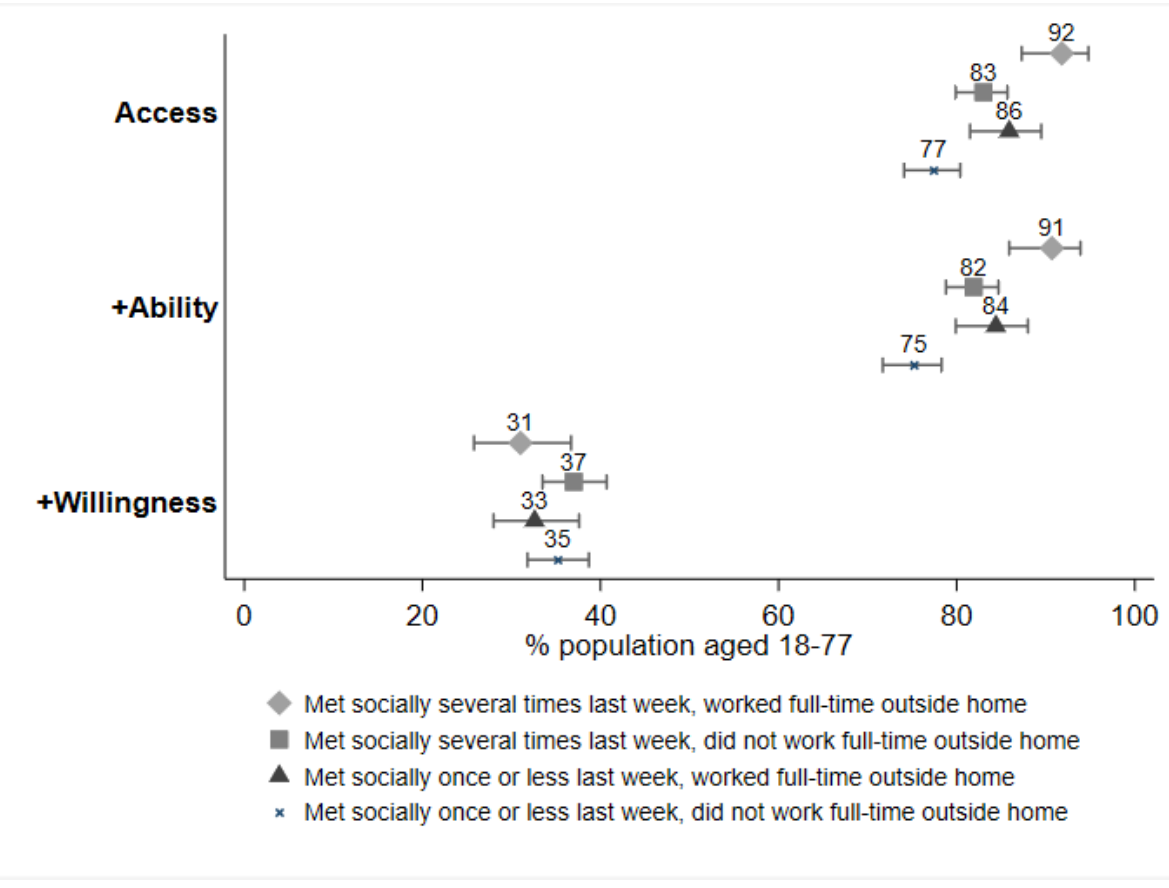
Figure 2. Predicted adoption rates by potential to spread SARS-CoV-2 (access: N=3267; ability: N=3267; willingness: N=3266). Error bars represent 95%